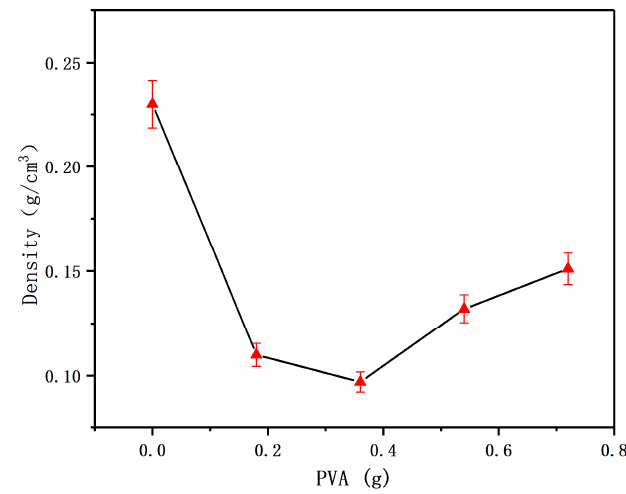
Figure 4. Effect of polyvinyl alcohol (PVA) dosage on density.